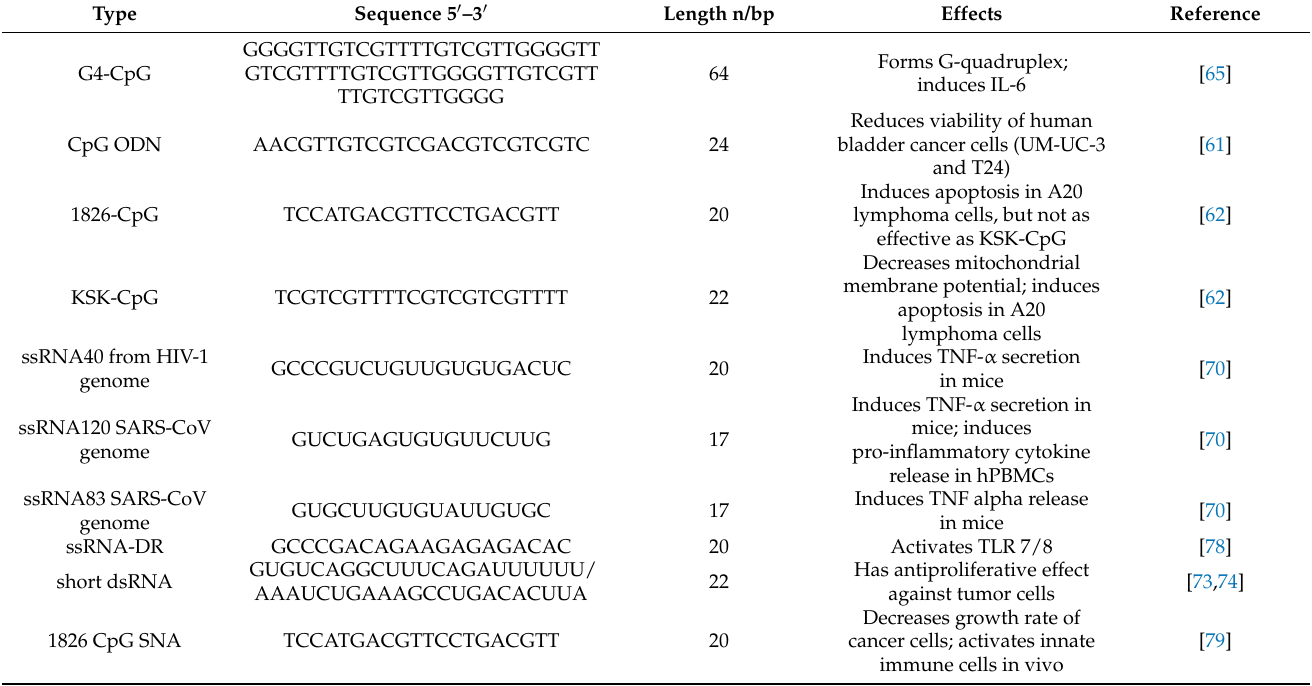
Table 1. Experimentally studied immunostimulating nucleic